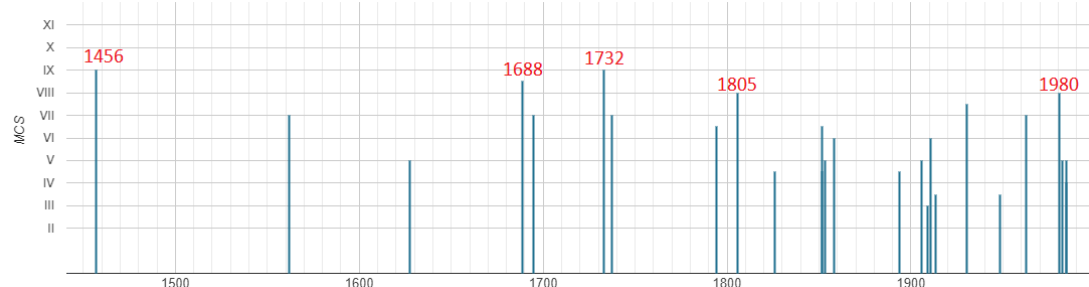
Figure 2. Seismic history of Avellino. The locality was hit by about ten earthquakes with site intensity greater than or equal to VII MCS (Data Source: [1], intensities in MCS scale). The dates of the earthquakes with Is ≥ VIII are reported in red (5 December 1456, 5 June 1688, 29 November 1732, 26 July